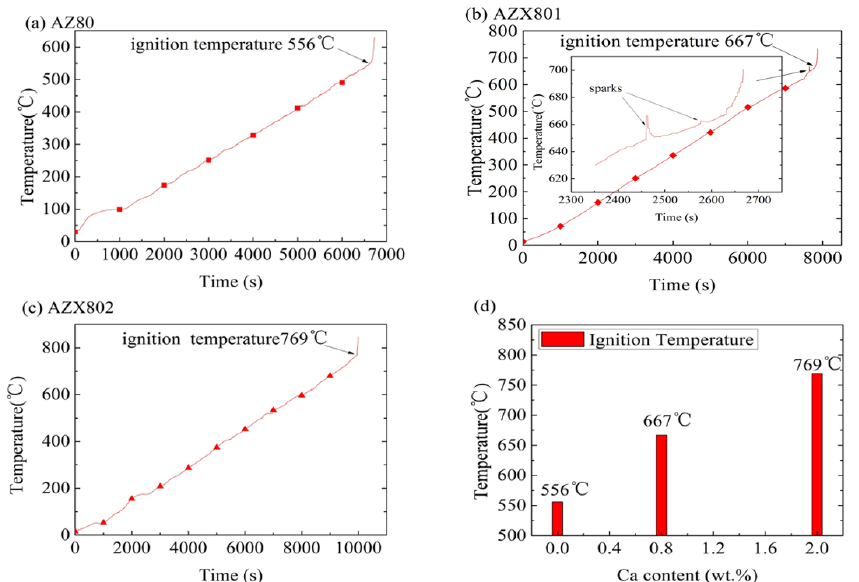
Figure 6. The ignition temperature test curves of the studied alloys ( a ) AZ80, ( b ) AZX801, ( c ) AZX802 and ignition temperatures of all alloys ( d ). The sample is heated in a small electric resistance furnace with a corundum crucible at a rate of 5 °C/min from room